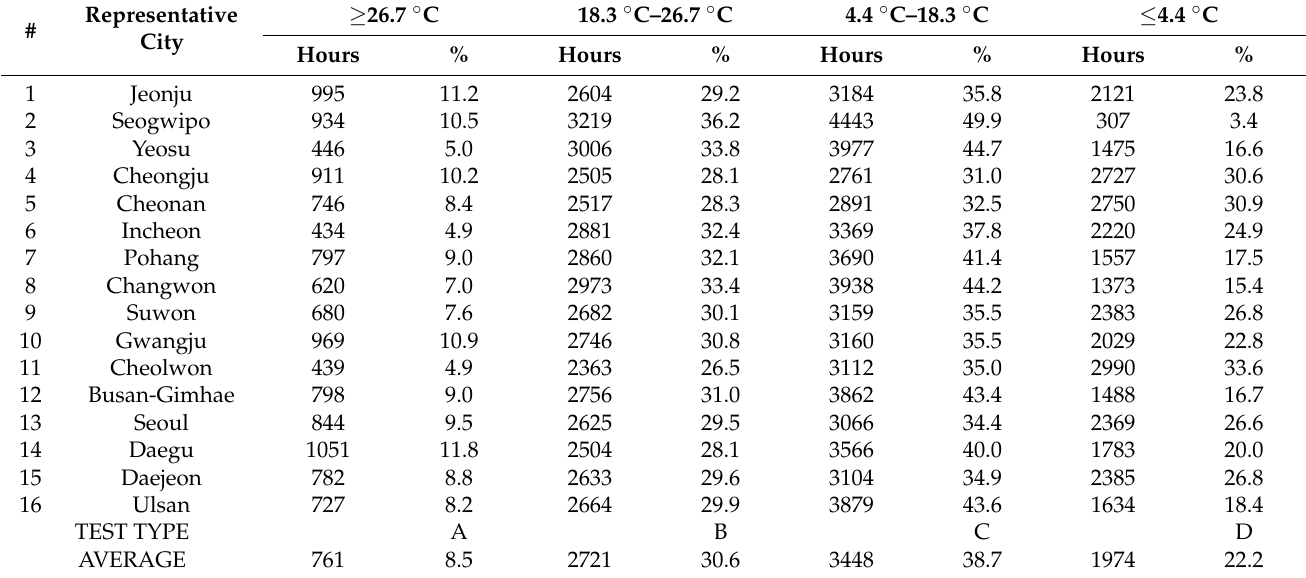
Table 8. Climate bin temperature data for normalized